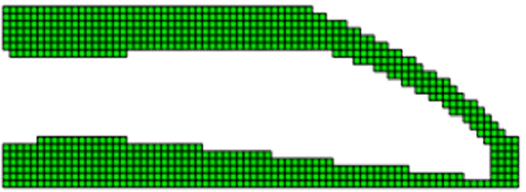
Figure 14. Solution of the optimization problem considering the anisotropy of the reinforcement material and the stiffness of the base material.